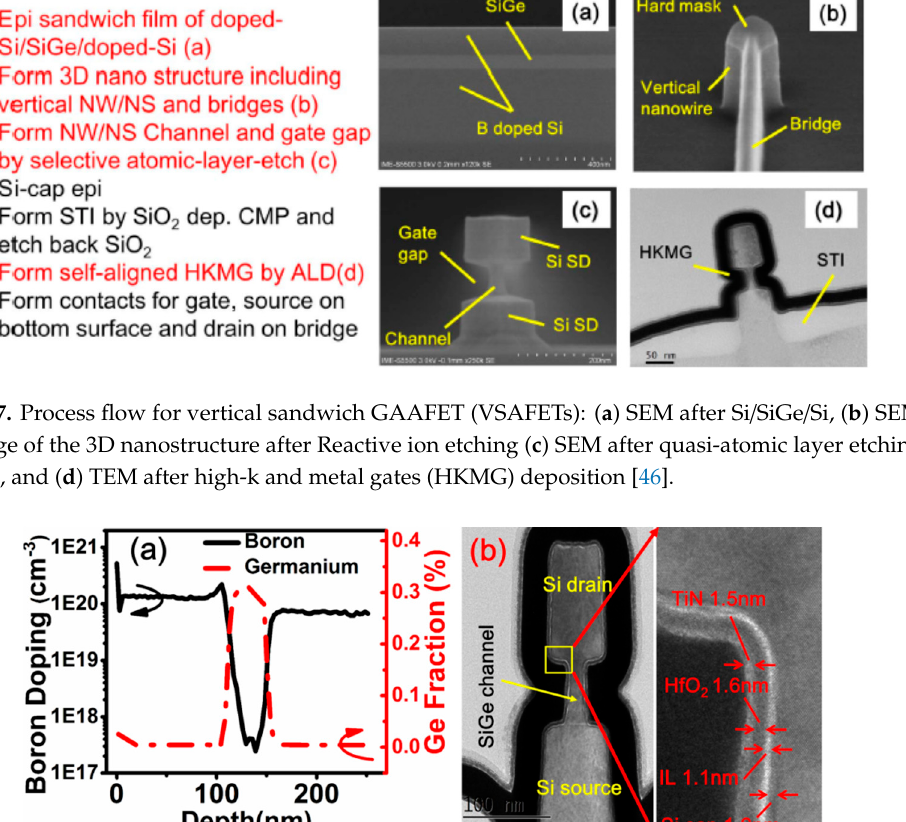
Figure 7. Process flow for vertical sandwich GAAFET (VSAFETs): ( a ) SEM after Si/SiGe/Si, ( b ) SEM tilt image of the 3D nanostructure after Reactive ion etching ( c ) SEM after quasi-atomic layer etching